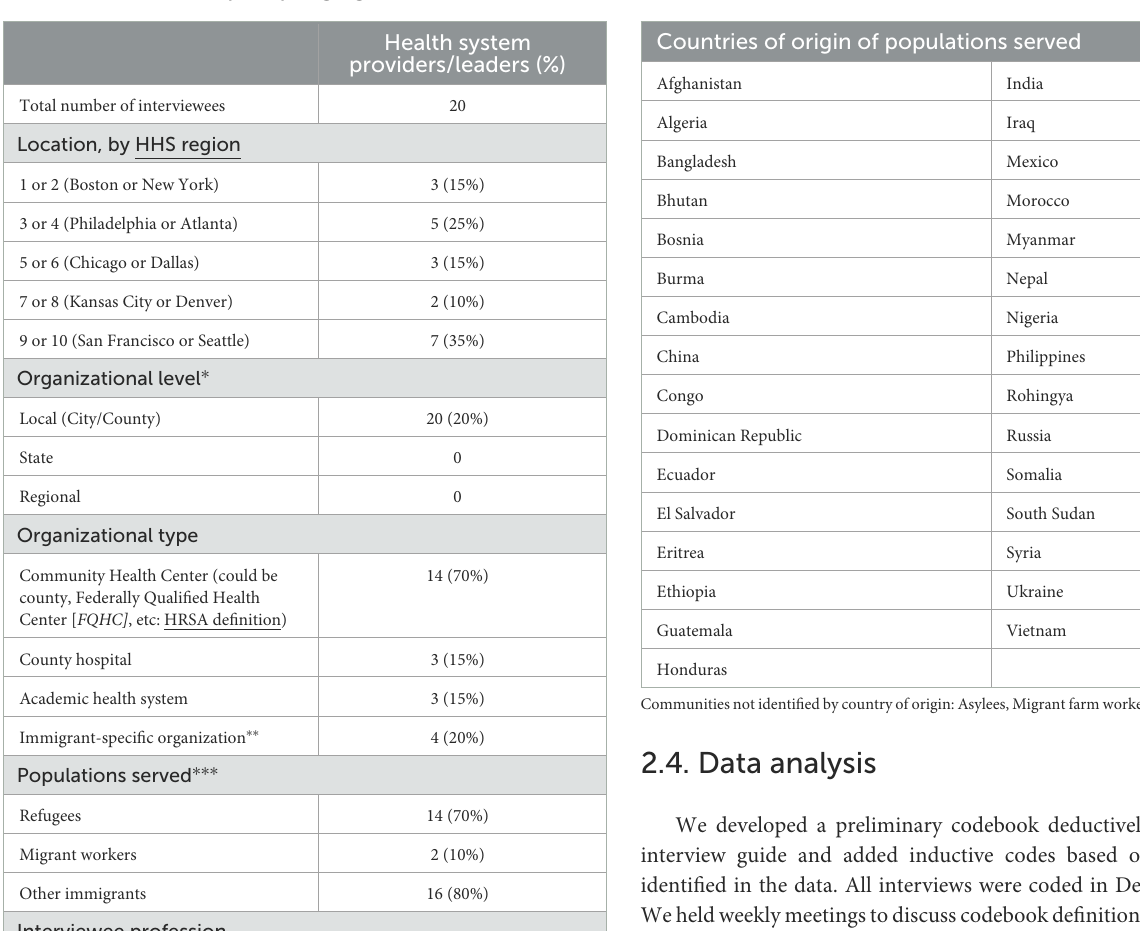
TABLE 1 Characteristics of participating organizations ( N = 20). TABLE 2 Countries of origin of populations